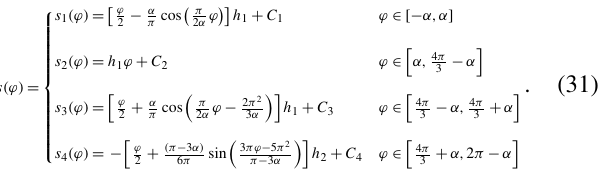
Figure 9. Piston maximum accelerations with respect to transition angles α of cam A.